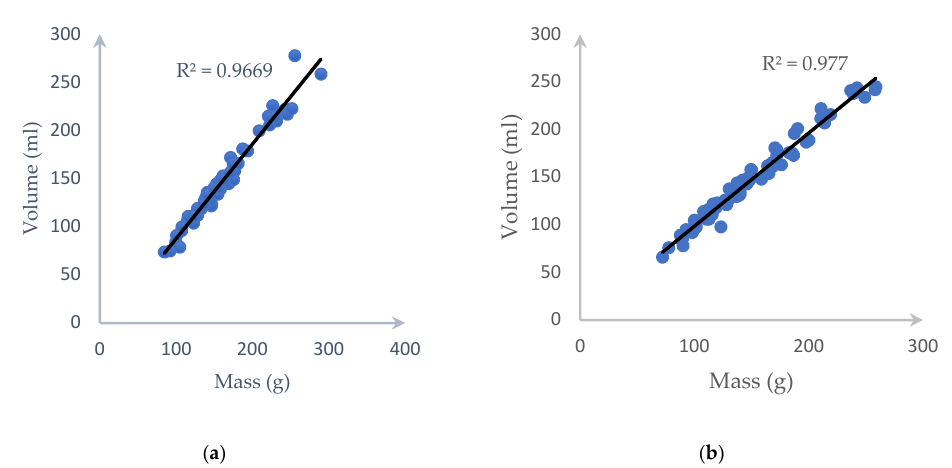
Figure 14. R 2 and correlation between the mass measured by the digital scale and volume measured by the water displacement method for ( a ) a carrot and ( b ) a cucumber.